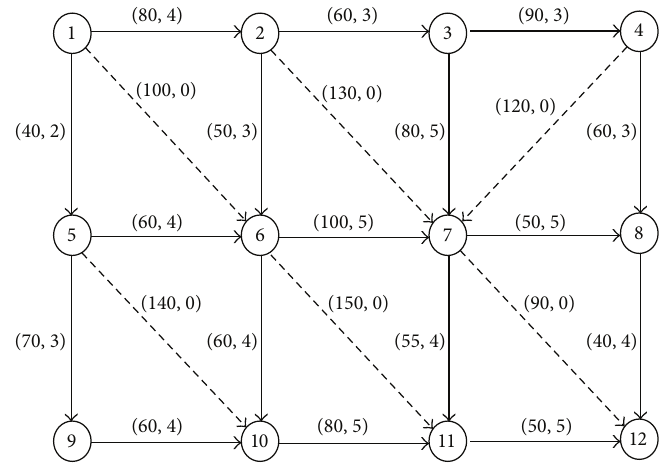
Figure 3: 12-node transportation network.